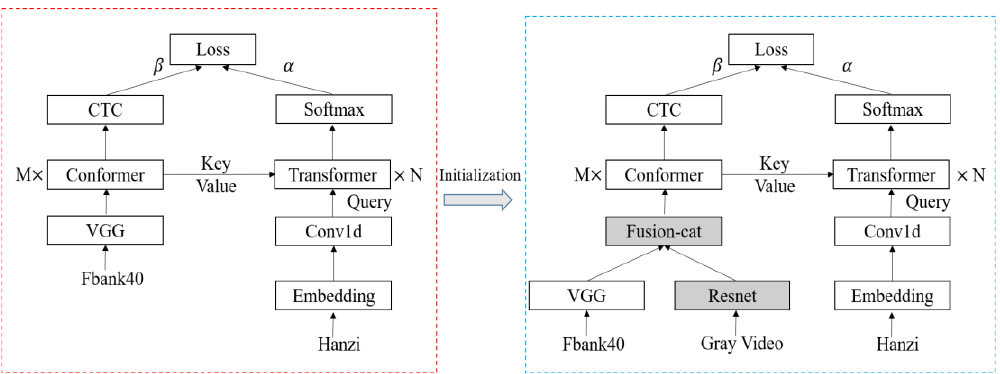
Figure 3. Pre-training with the end-to-end ASR system.